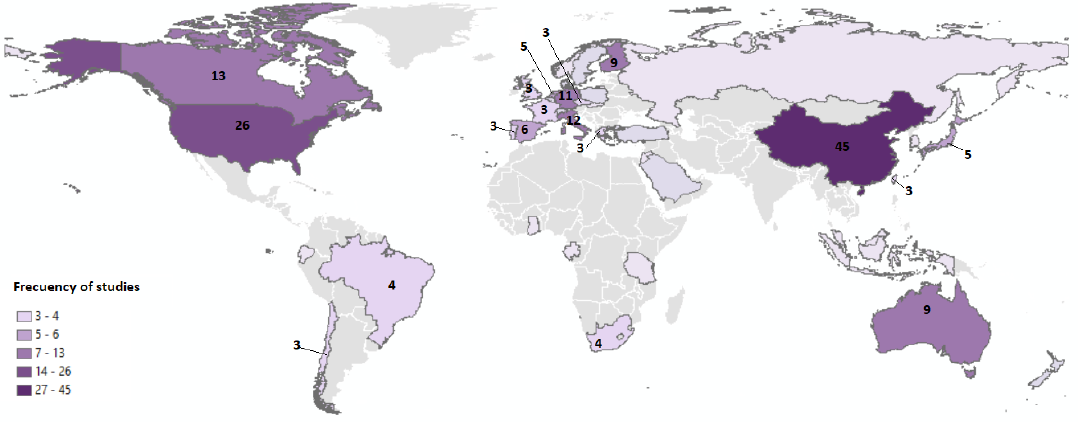
Figure 6. World distribution of relevant studies.